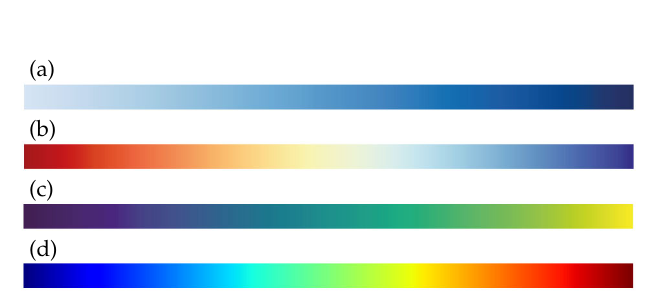
Figure 1. The colormaps used in this study: ( a ) blue (single-hue, sequential); ( b ) RdYlBu (diverging); ( c ) viridis (multi-hue, sequential, perceptually uniform); and ( d ) jet